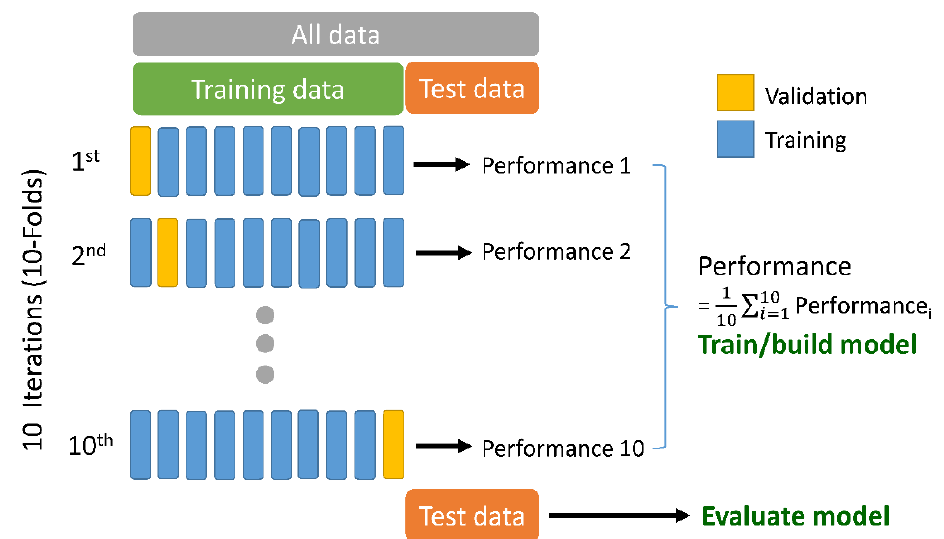
Figure 3. Schematic overview of the 10-fold cross-validation and the excluded test dataset.